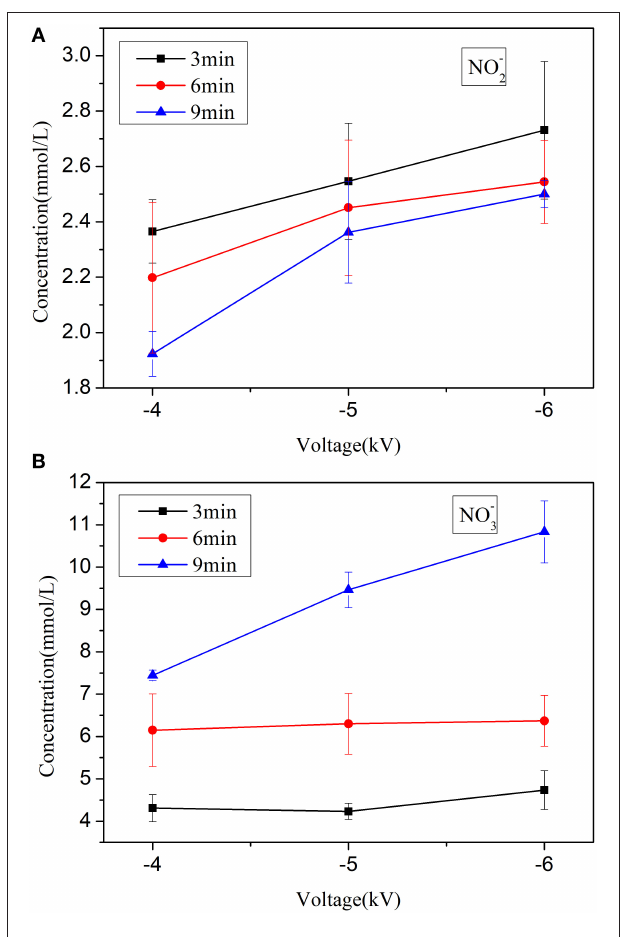
FIGURE 7 | UV absorbance: (A) NO − 2 and (B) NO − 3 at various voltages and treatment